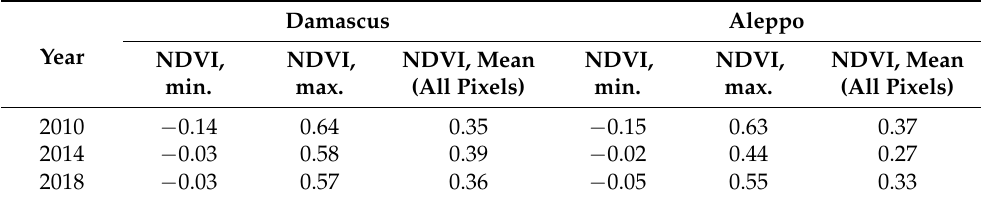
Figure 4. NDVI Spatial Distribution in Damascus and Aleppo between 2010 and 2018. Table 6. Value of normalized difference vegetation index (NDVI) for Damascus and Aleppo for the period between 2010 and